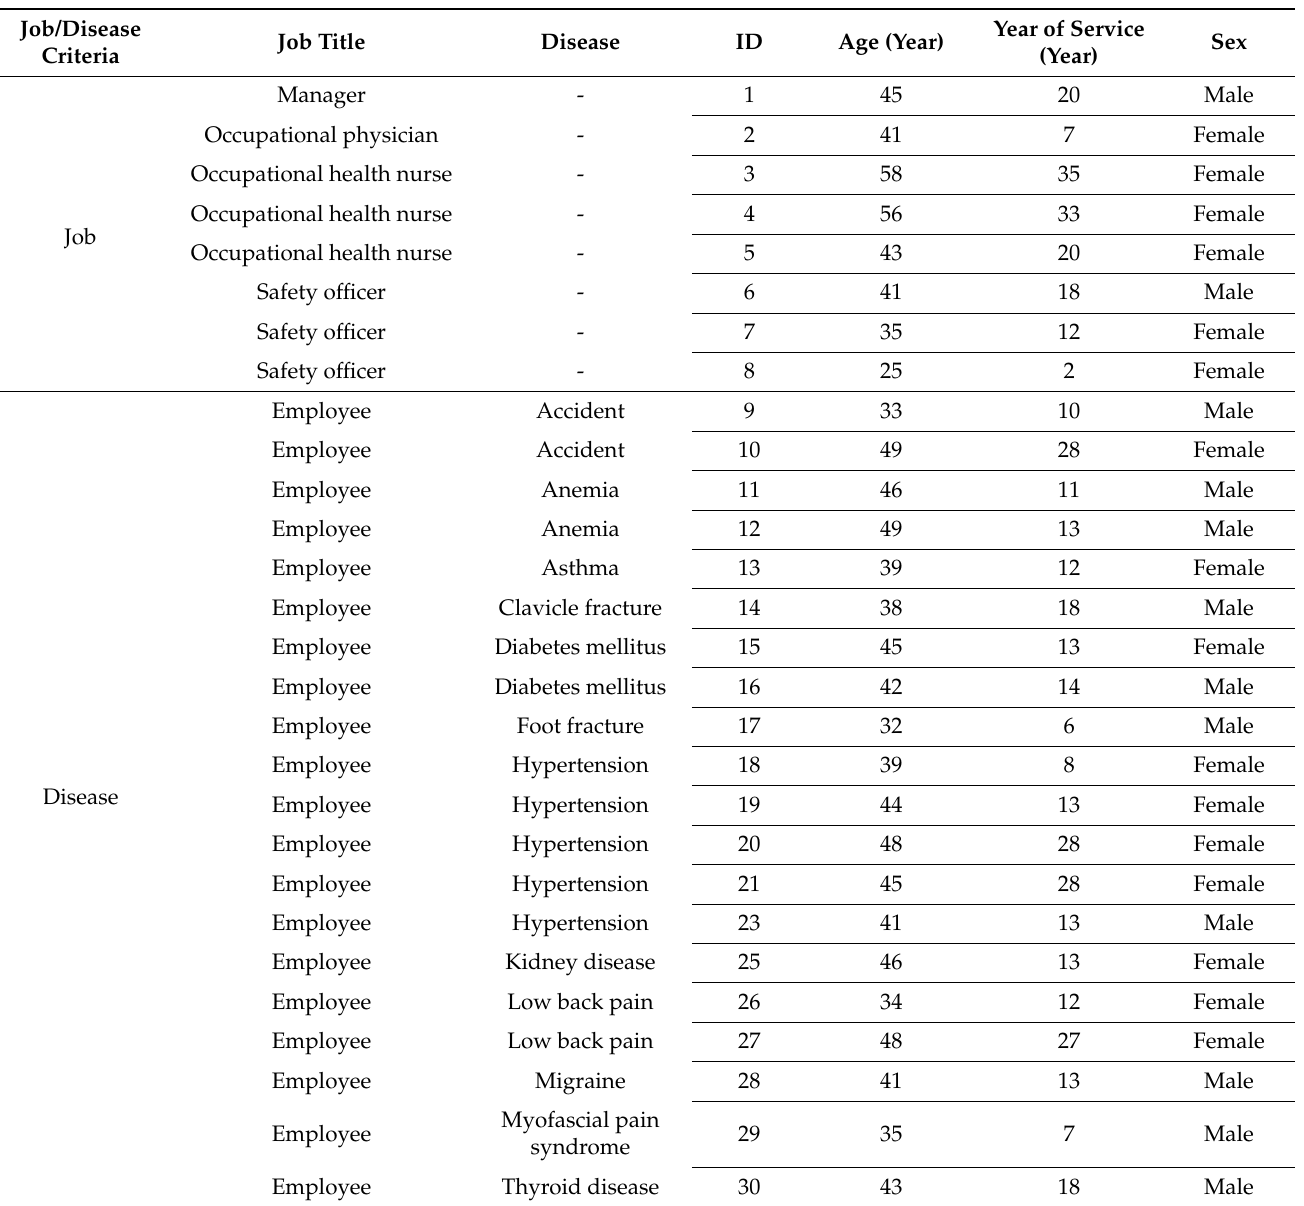
Table 6. Participants’ demographic